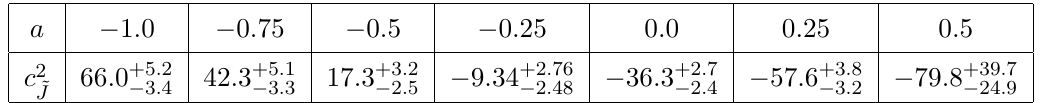
, determined by eq. (3.7) and ~ J (1) in table c